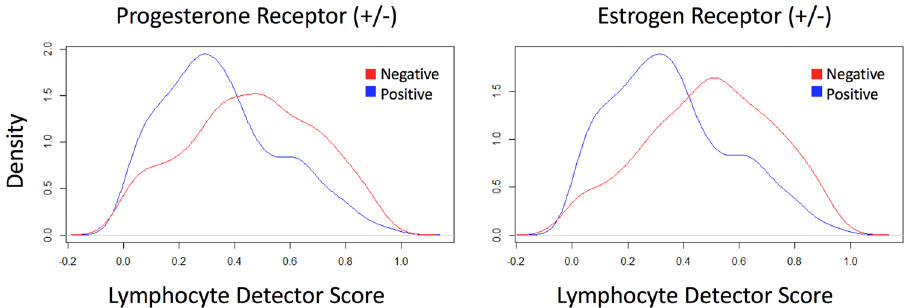
Fig. 2 Lymphocyte in fi ltration patterns distinguished progesterone receptor and estrogen receptor statuses. The distributions of visible lymphocytes for progesterone receptor (left) status + / − and estrogen receptor (right) status + / − are